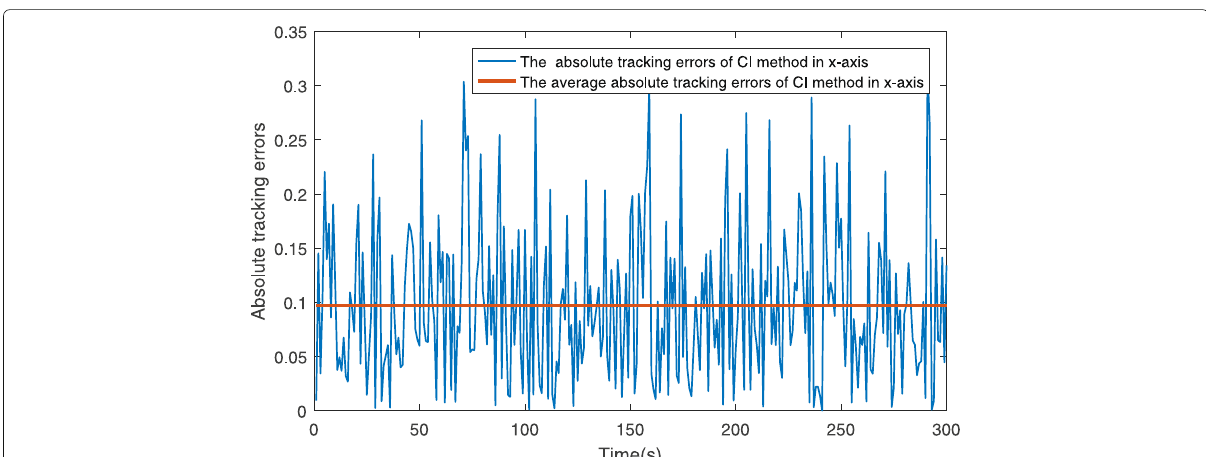
Fig. 14 The absolute tracking errors of CI method in x -axis with a i = 14